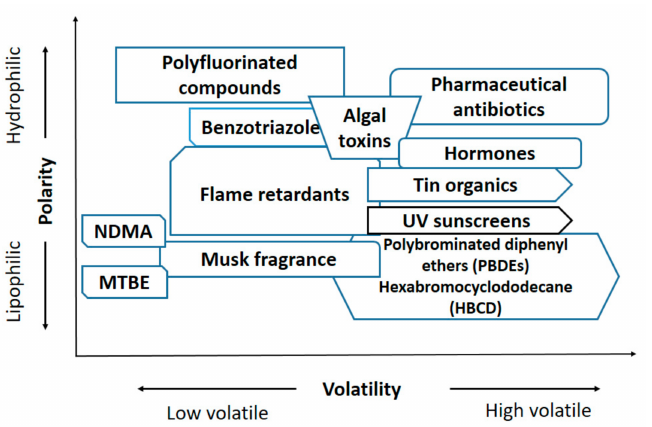
Figure 2. Emerging pollutants volatility and polarity (adapted upon